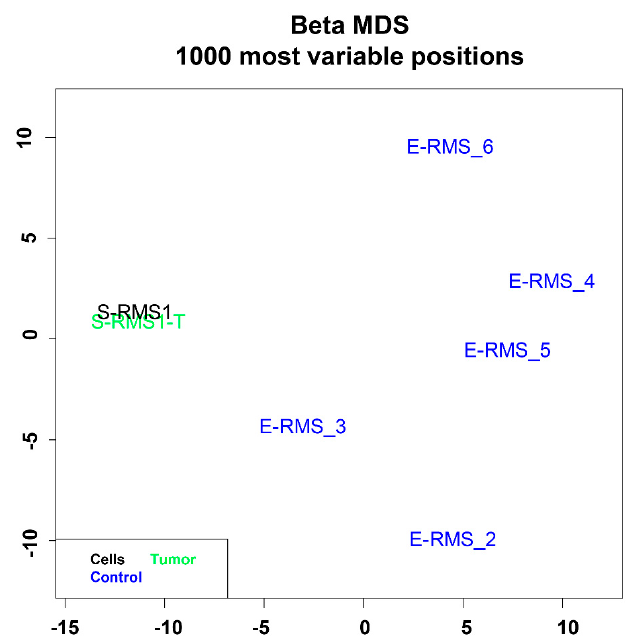
Figure 3. Genome-wide DNA methylation profiling on RMS samples and cell line. MDS (multidimensional scaling) analysis performed on the 1000 most variable probes of the whole genome DNA methylation data shows a close similarity between S-RMS1 cell line and tumor tissue (T). Color legend of the MDS plot as follows: S-RMS1 cell line (S-RMS1, black); S-RMS1 tumor (S-RMS1-T, green); E-RMS_2, 3, 4, 5, 6 embryonal rhabdomyosarcomas as controls (blue).